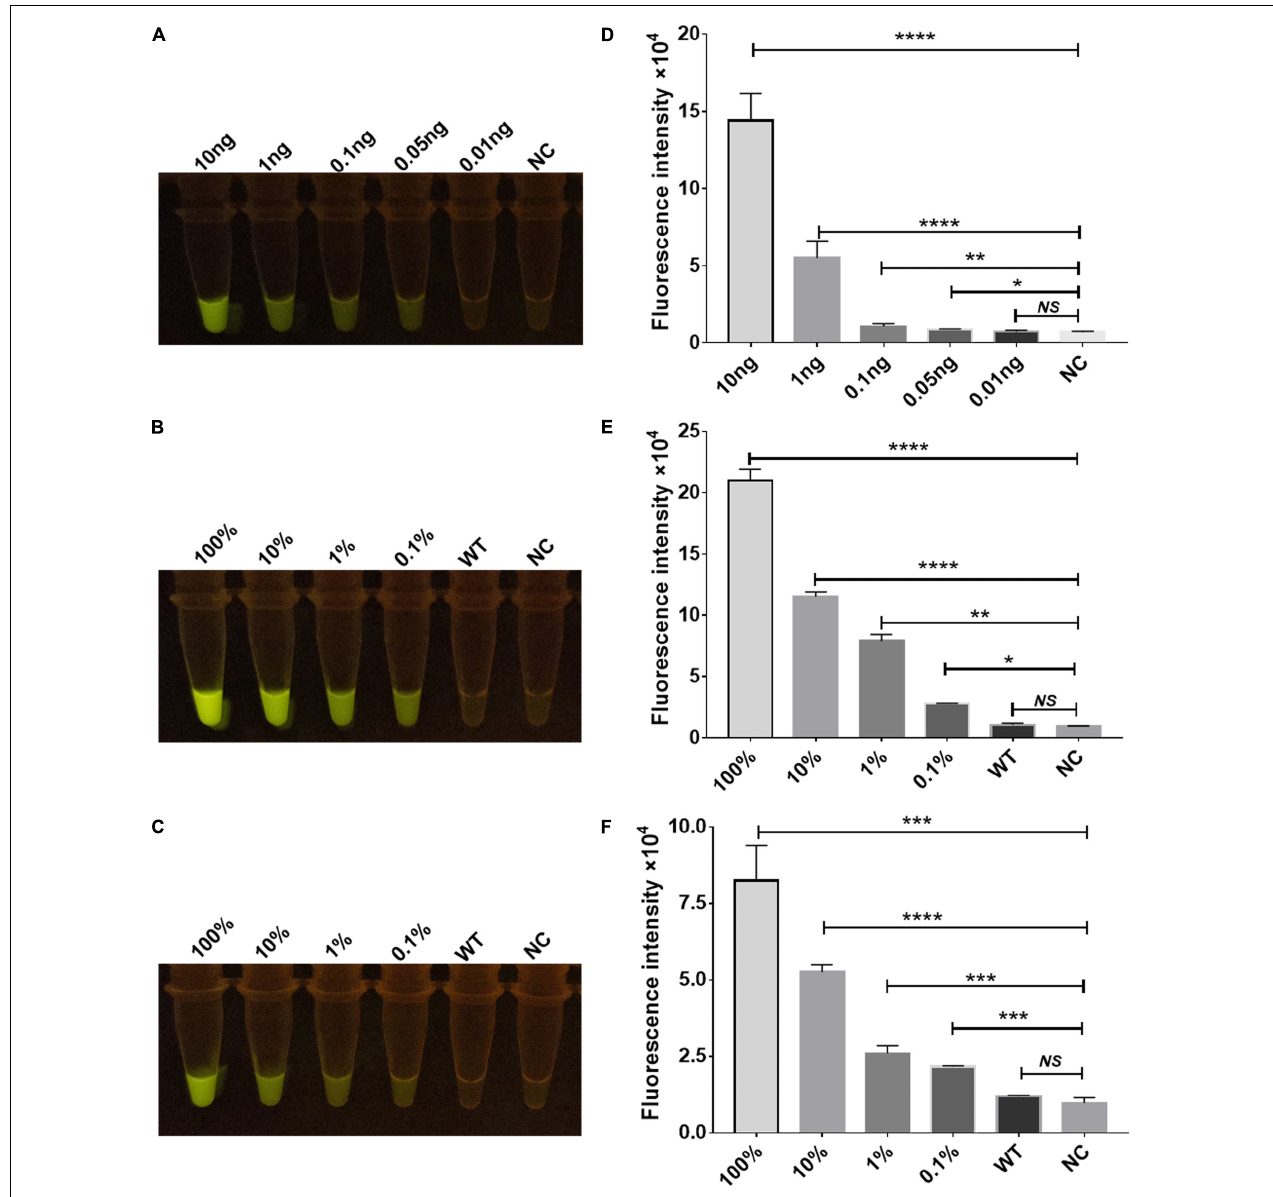
FIGURE 5 | Sensitivity and specificity verification of the Cas12a RR detection system. Sensitivity assay using rpsl-crRNAmix to detect gradient-diluted rpsl gene RNA from 10 to 0.01 ng (A,D) . Specificity (B,C,E,F) of the Cas12a RR fluorescence method for detecting the rpsl gene of streptomycin-resistant M.tb. The wild-type M. tuberculosis and streptomycin-resistant M. tuberculosis genome nucleic acids were mixed in different proportions to obtain test samples with mutation rates of 100, 10, 1, 0.1, and 0%. The fluorescent images (A–C) and fluorescence intensity (D–F) at 15 min of reaction are shown. Data are presented as the mean ± SEM from at least three independent experiments. * p < 0.05, ** p < 0.01, *** p < 0.001, and **** p <